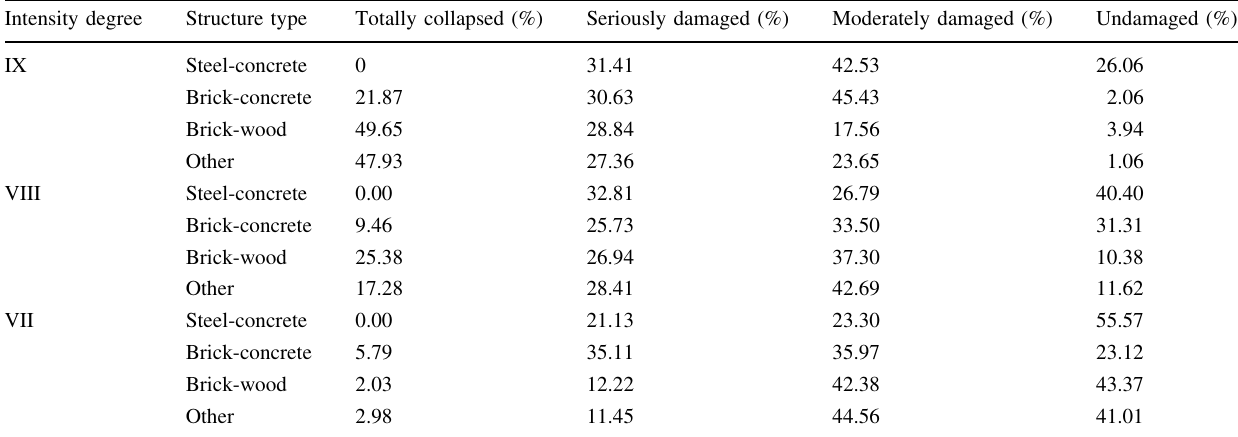
Table 6 Calibrated building damage proportion matrix for the 2014 Ludian Earthquake, Yunnan Province, China Intensity degree Structure